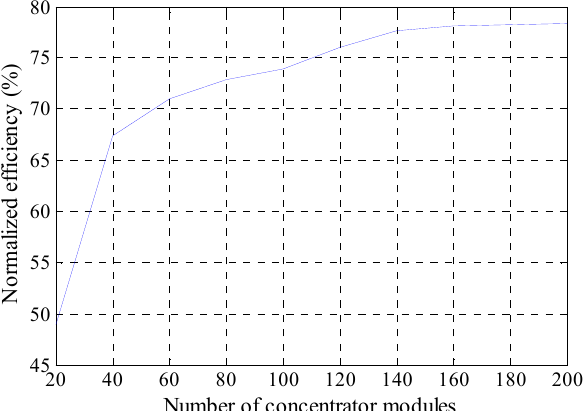
Figure 11. Variation of normalized efficiency with a different number of modules. Table 4. Variation of the collection efficiency with different N .